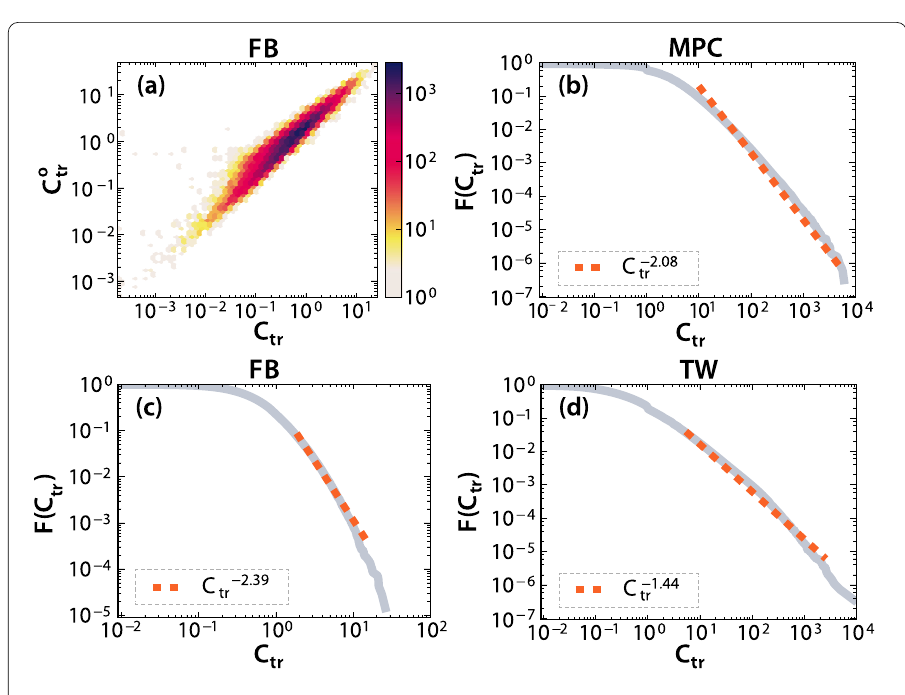
Figure 2 ( a ) Correlation heat-map plot between the C o tr exact and approximated C tr transmission centrality values of the FB network. Approximate measures were initiated from 5000 seeds and unbiased in d = 3 distance. ( b ), ( c ), ( d ) F ( C tr ) = P ( C (cid:8) tr ≤ C tr ) cumulative distribution functions of transmission centrality values in the MPC, FB, and TW networks respectively. C tr values were averaged for each link from respectively